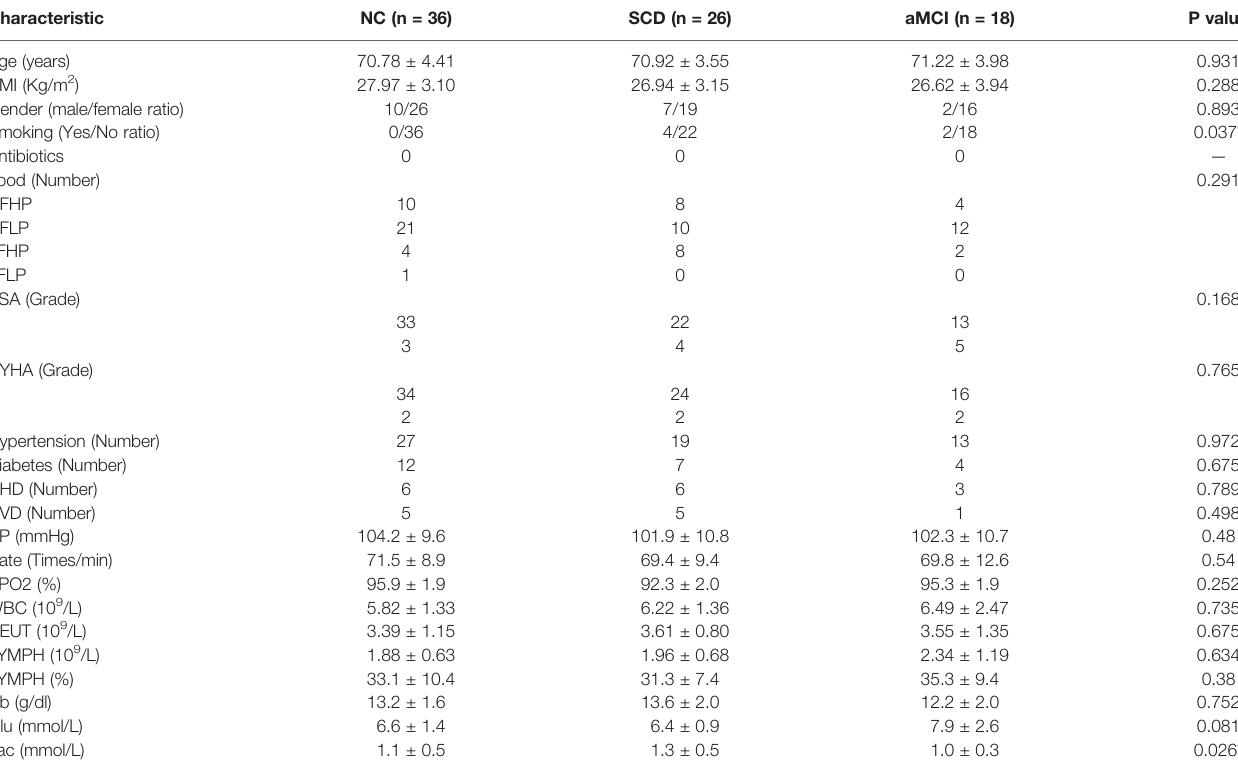
TABLE 1 | Characteristics and perioperative data of the study population.